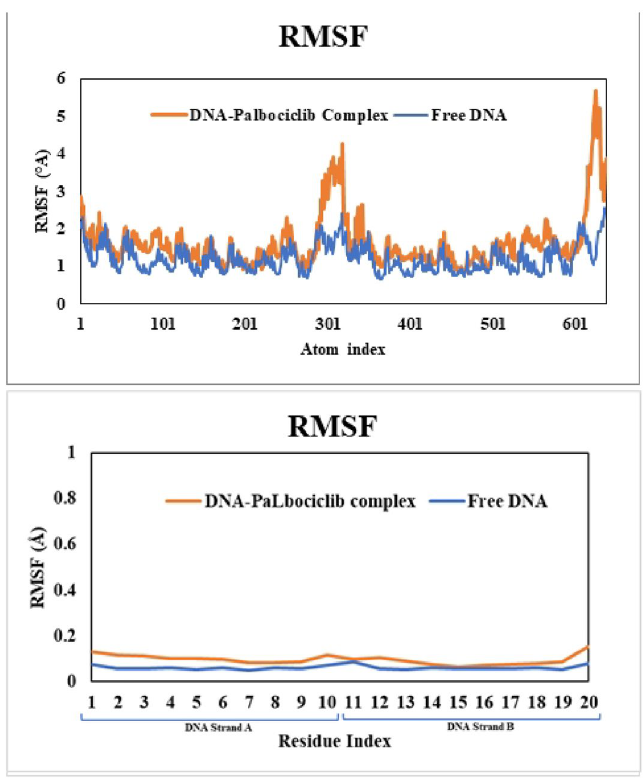
Figure 12. RMSF curves for free DNA (3EY0) (blue curve) and its complex with PLB (orange curve) after 50 ns dynamic simulation experiments per atom (Top) and DNA bases (Bottom) for strand A (atom 1–319, residue 1–10) and strand B (atom 320–638, residue